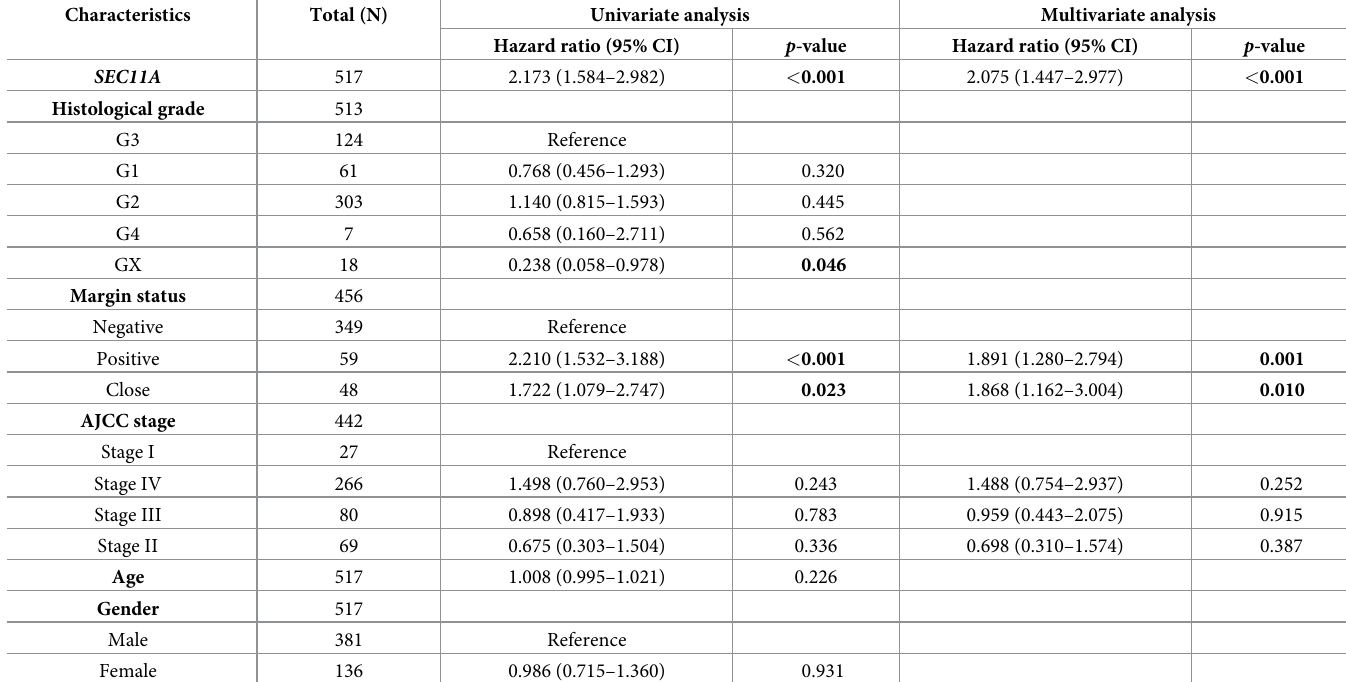
Table 2. Univariate and multivariate analysis for PFS.